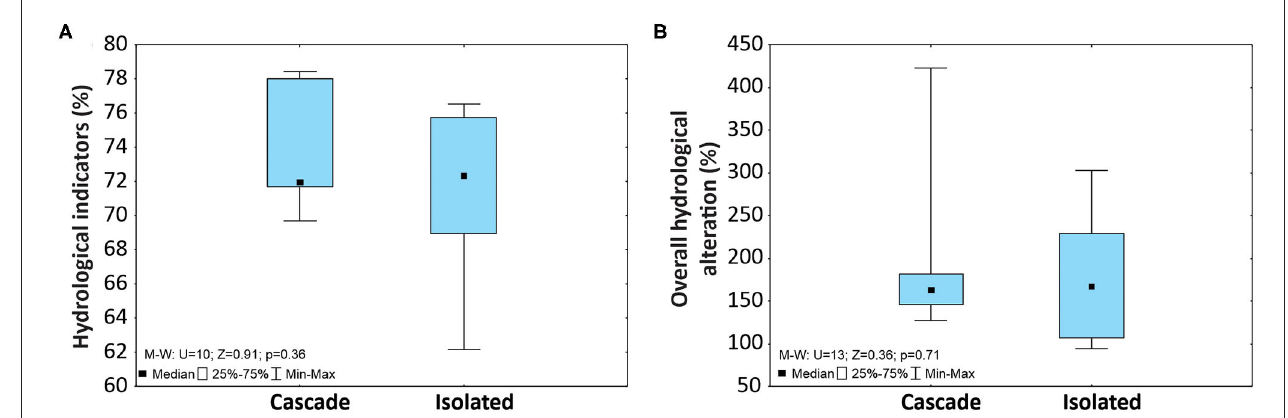
FIGURE 6 | Comparison between reaches containing more than one hydropower facility (cascades) with those containing a single facility (isolated) showing no significant differences in either (A) the percentage of significant indicators of hydrological alteration or (B) the overall